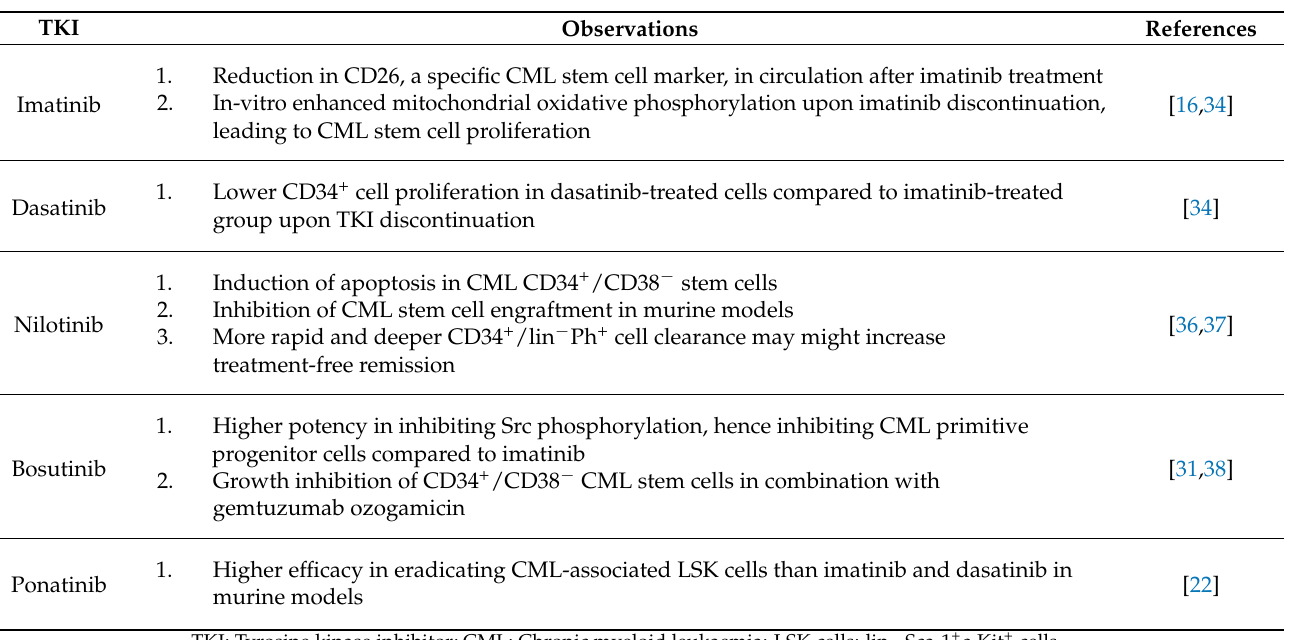
Table 1. Tyrosine kinase inhibitors and their effects on CML stem